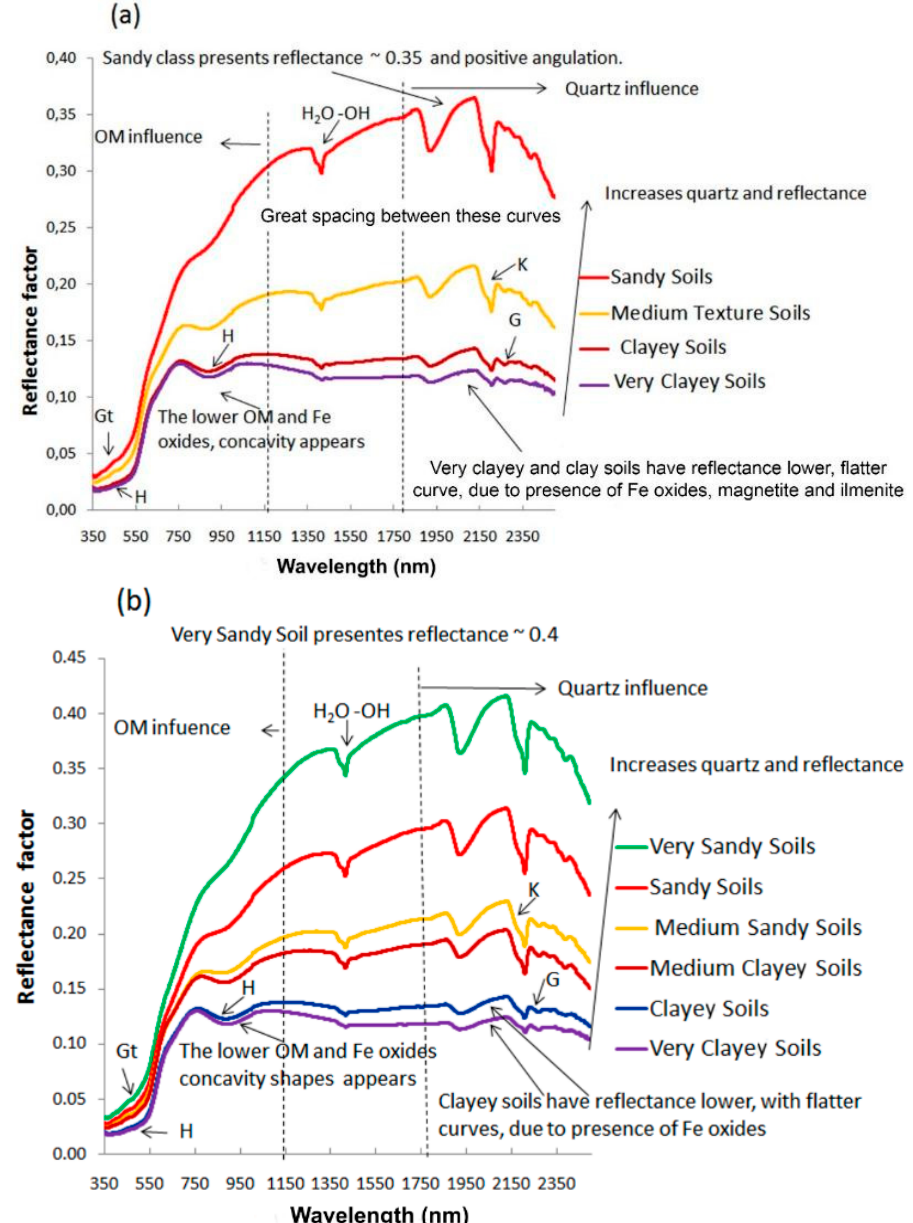
Figure 2. ( a ) Spectral curves of the studied soils individualized for simplified textural groupings SiBCS and ( b ) textural groupings in LBTC: K, kaolinite; G, gibbsite; H, hematite; and Gt, goethite